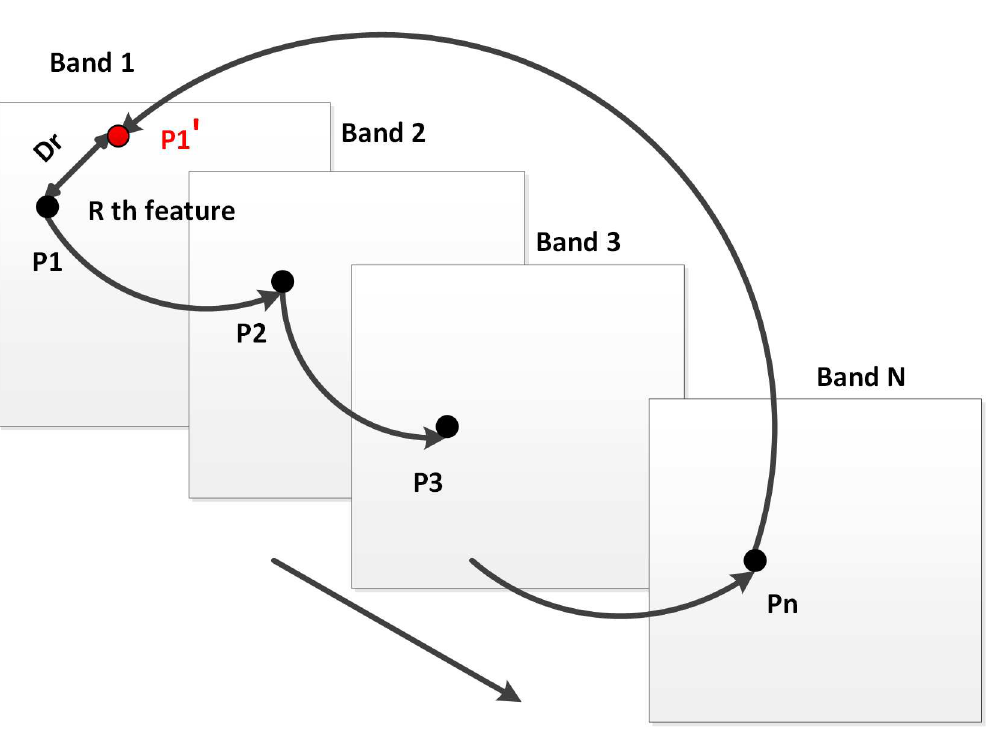
Fig 2. Diagram of kicking out